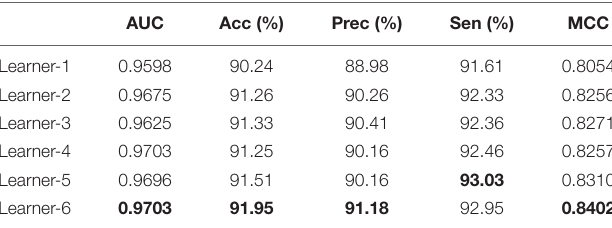
TABLE 4 | Performances of different drug descriptions on the ion channel